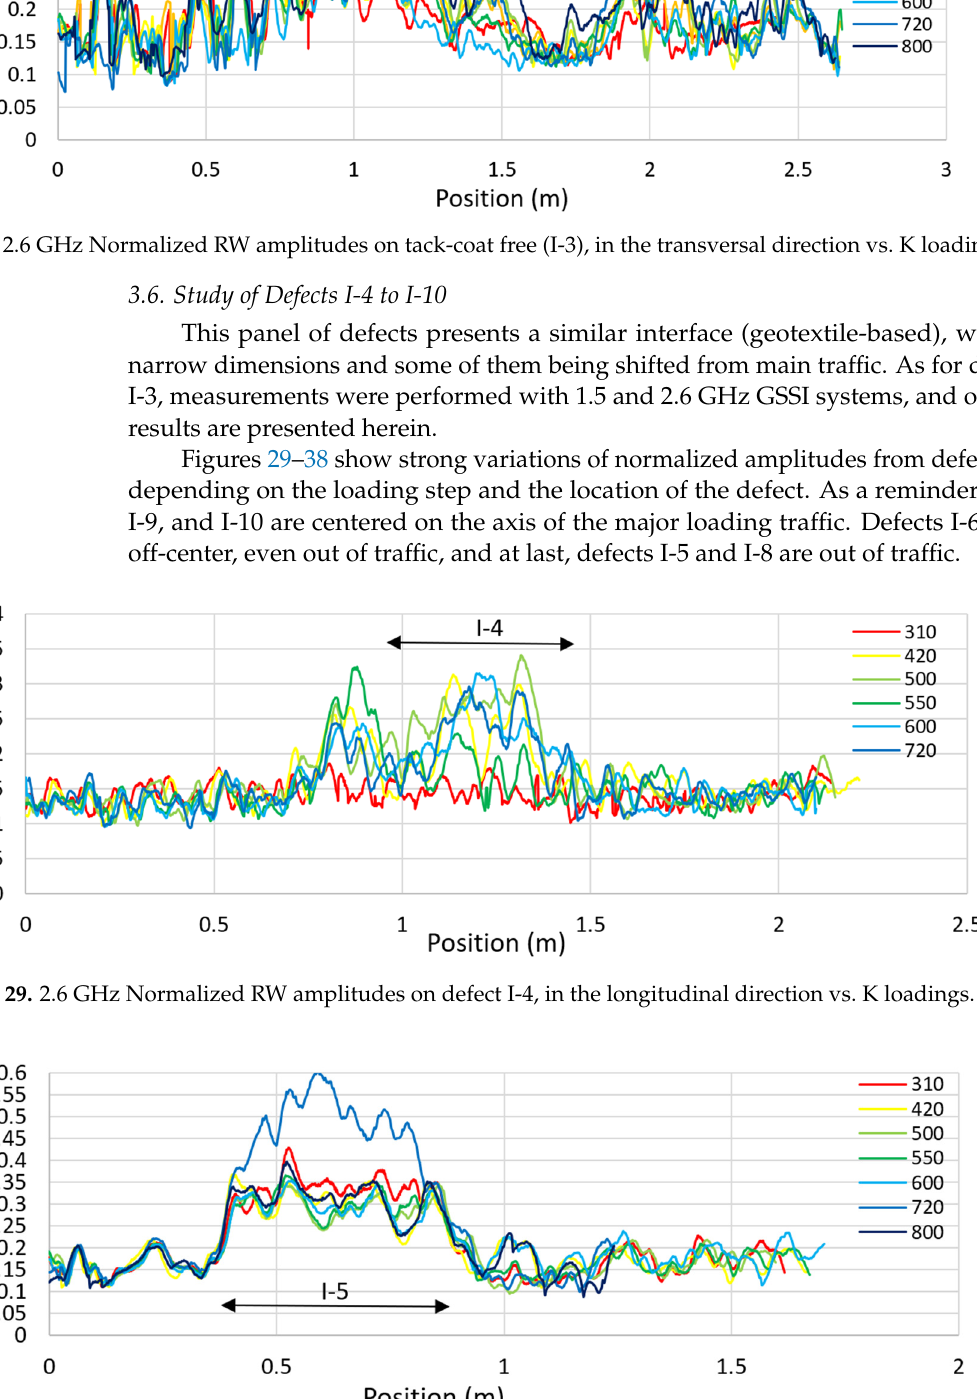
Figure 28. 2.6 GHz Normalized RW amplitudes on tack-coat free (I-3), in the transversal direction vs. K loadings.